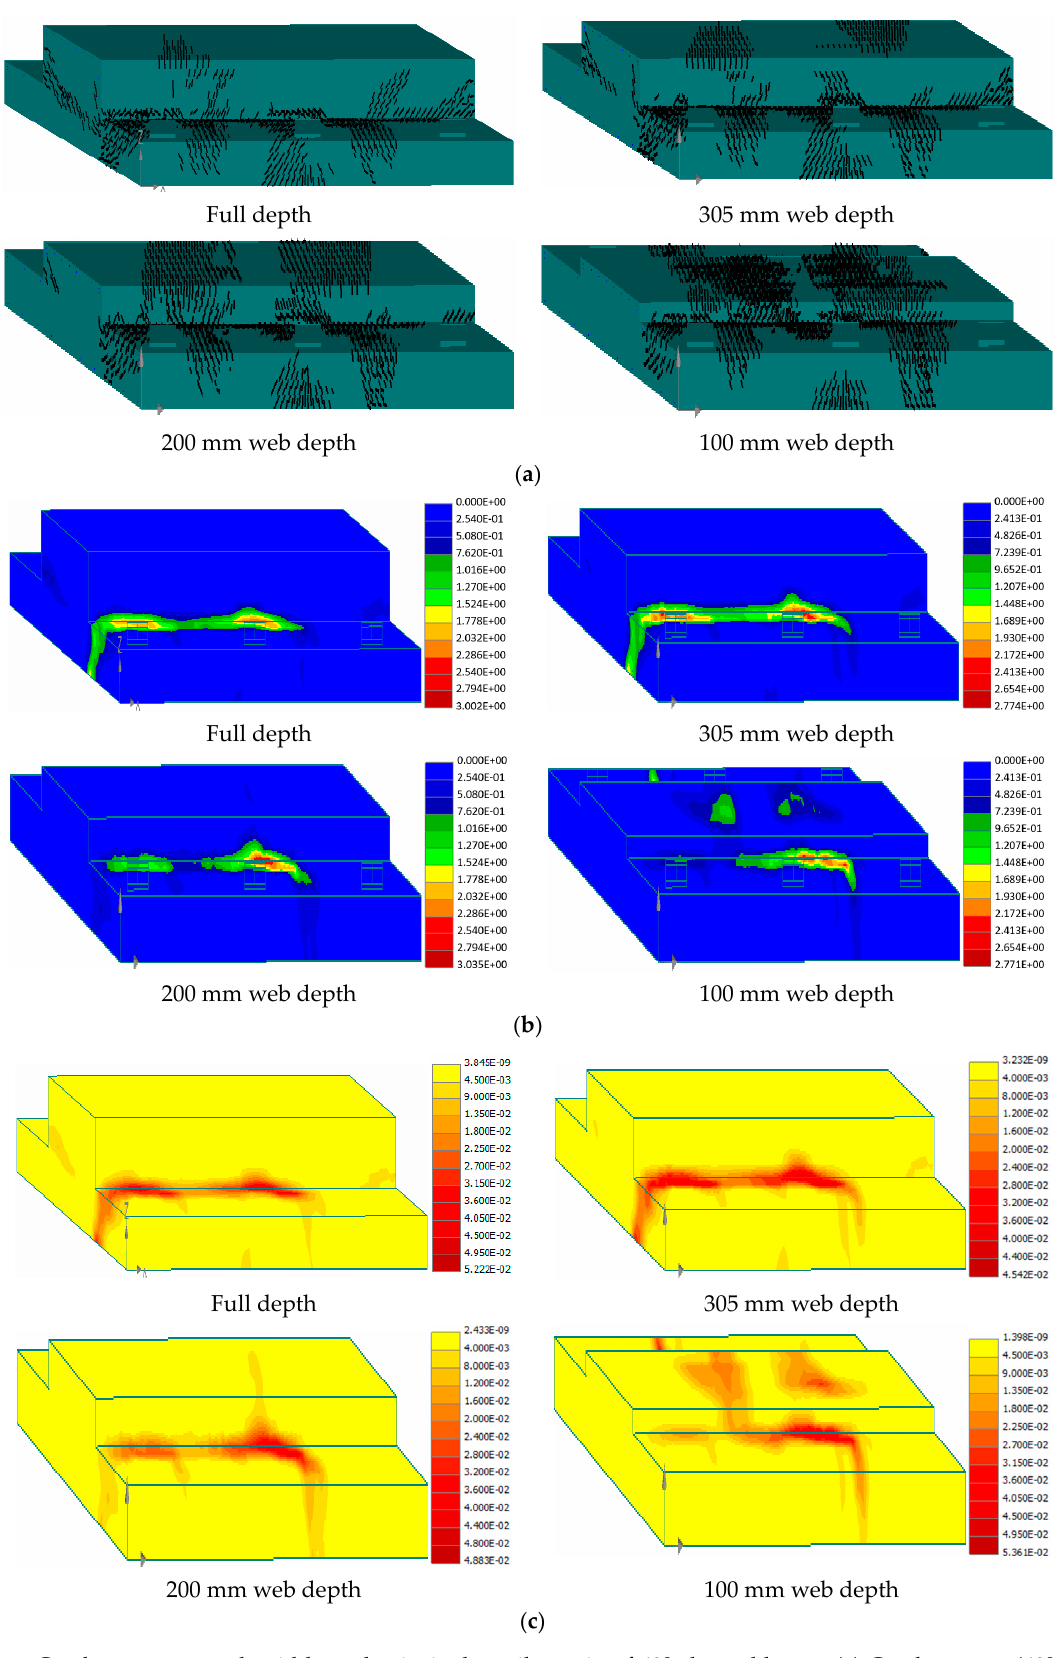
Figure 16. Crack patterns, crack width, and principal tensile strain of 60° skewed beam: ( a ) Crack pattern (60° skew); ( b ) Crack width (60° skew); ( c ) Principal tensile strain (60° skew).